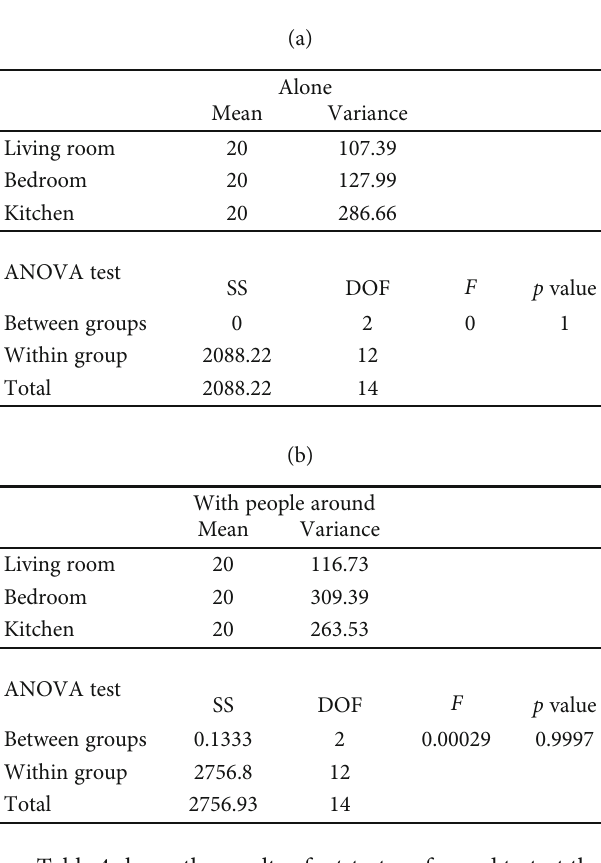
Table 4: t -test for the comparison among each type of interaction when the user was alone and with few people